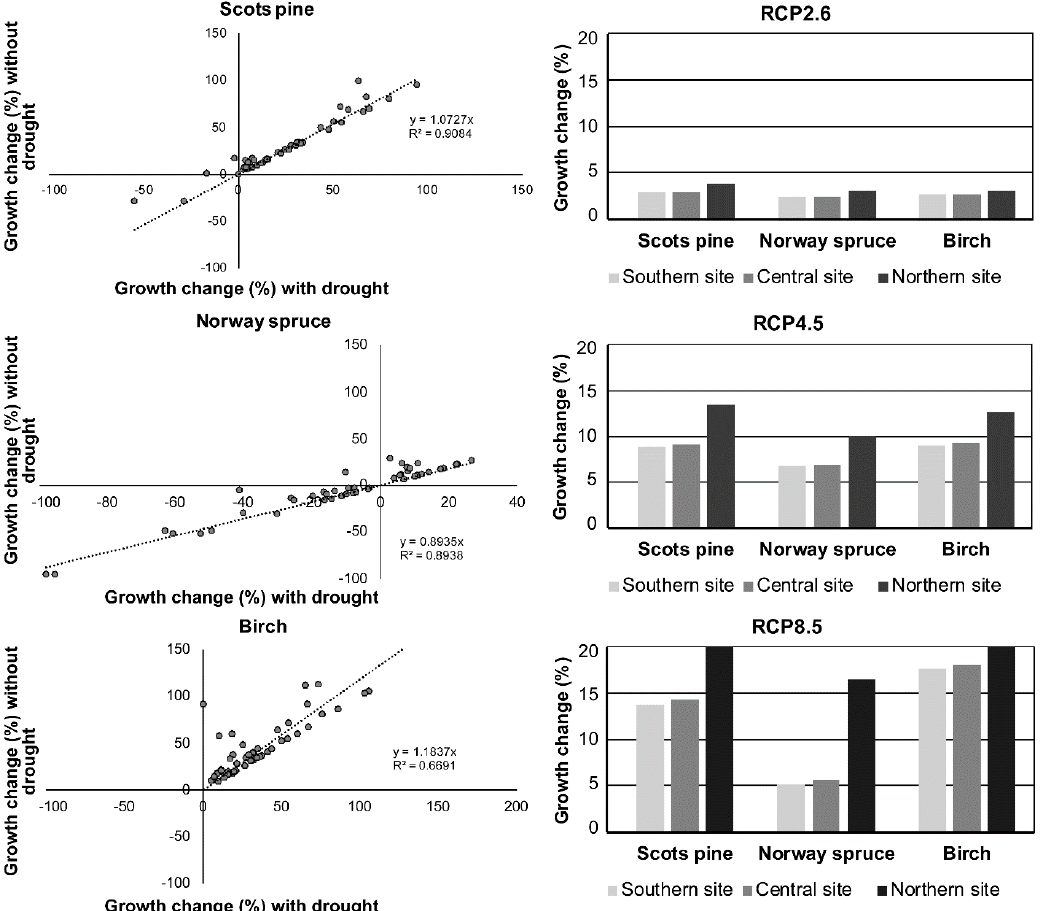
Figure 3. Left: The relationship for change (%) of diameter growth responses of Scots pine, Norway spruce, and birch when including (x-axis) and excluding (y-axis) the effects of drought on growth responses on quite poor and medium fertile (VT and MT) upland sites and corresponding drained peatland (Vtkg and Mtkg) sites, under minor (RCP2.6), moderate (RCP4.5), and severe (RCP8.5) climate change. The data points in the upper-right quadrant represent the sites in the north (Rovaniemi, 66 ◦ N), while those in lower left represent the sites in the south (Tampere, 61 ◦ N) over three 30-year periods. Right: The differences (%) in diameter growth responses in Scots pine, Norway spruce, and birch on medium fertile (MT) sites over the whole 90-year period with a fixed level of atmospheric CO 2 (350 ppm), and the gradually increasing CO 2 levels for each RCP scenario. The temperature and precipitation changes were specific to each RCP scenario in calculations on the southern (Tampere, 61 ◦ N), central (Kuopio, 63 ◦ N), and northern (Rovaniemi, 66 ◦ N) boreal